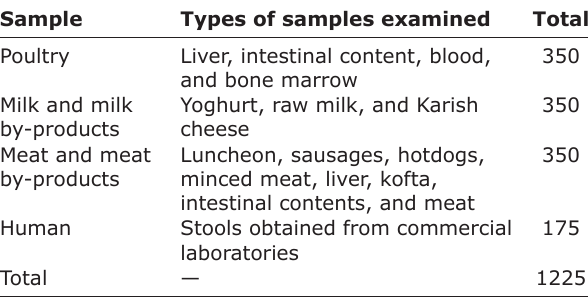
Table-1: Types and numbers of samples collected for examination.